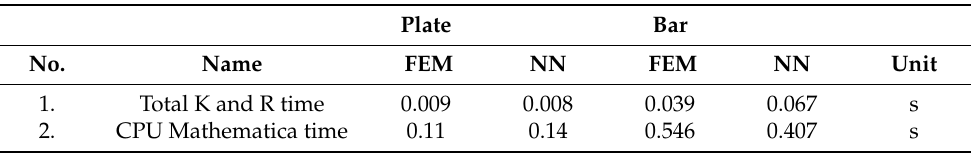
Table 3. 2D plate and A-notched bar—AceFEM simulation